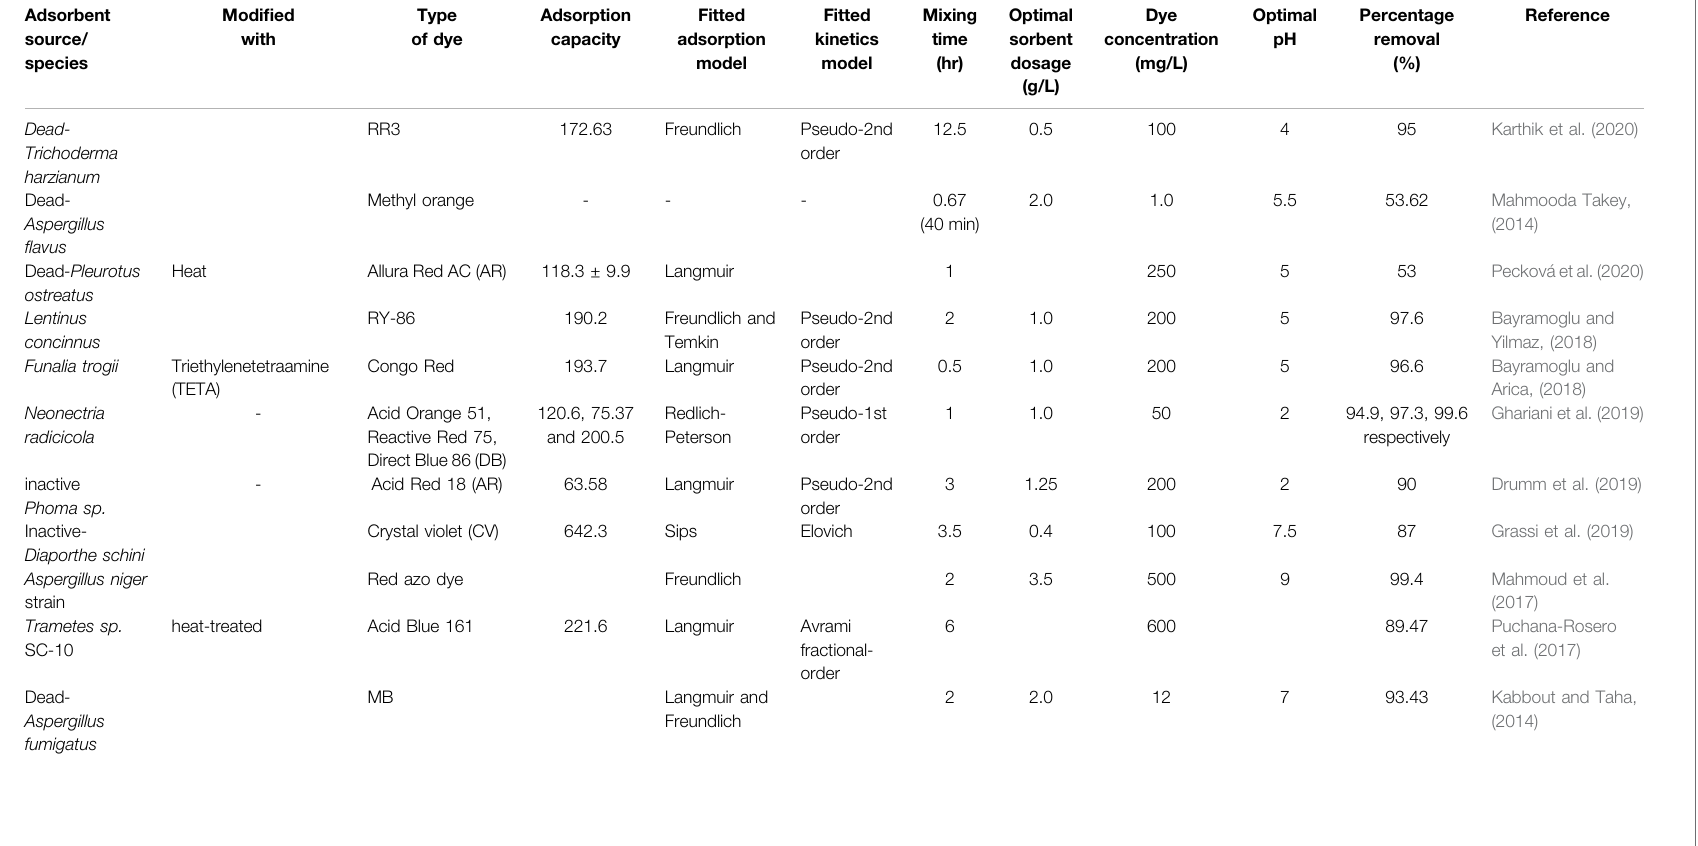
TABLE 3 | Application of some species from fungal biomass for dye